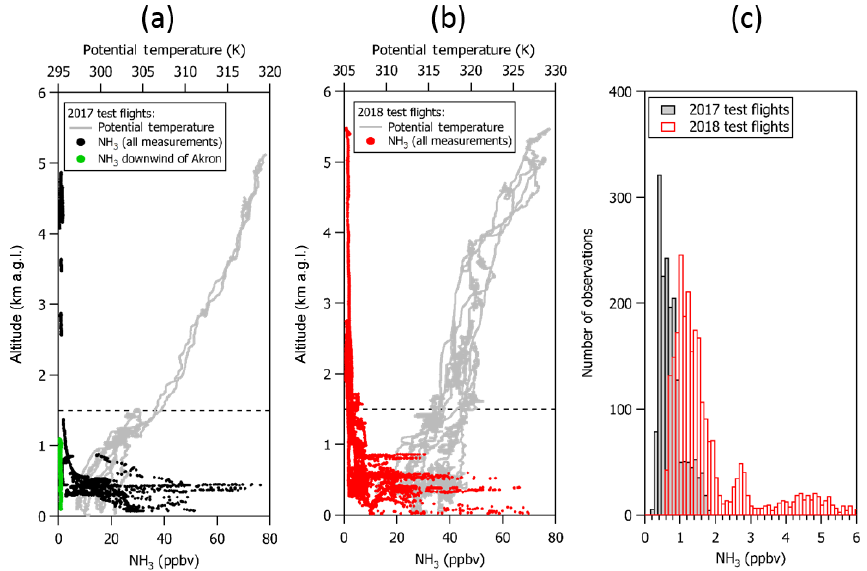
Figure 6. Vertical profiles of NH 3 (in ppbv) and potential temperature (in K) from (a) the first and third test flight in 2017 and (b) the test flights in 2018. NH 3 mixing ratios as high as 80ppbv were observed in the mixed boundary layer during missed approaches at Greeley-Weld County Airport and over northeastern Colorado compared to average mixing ratios of ∼ 0 . 8ppbv near Akron, Colorado, following several days of rain. (c) Histograms of the corresponding NH 3 measurements collected above 1.5kma.g.l. (dashed line) show that measurements were frequently larger than 200ppt, especially measurements that were collected in the free